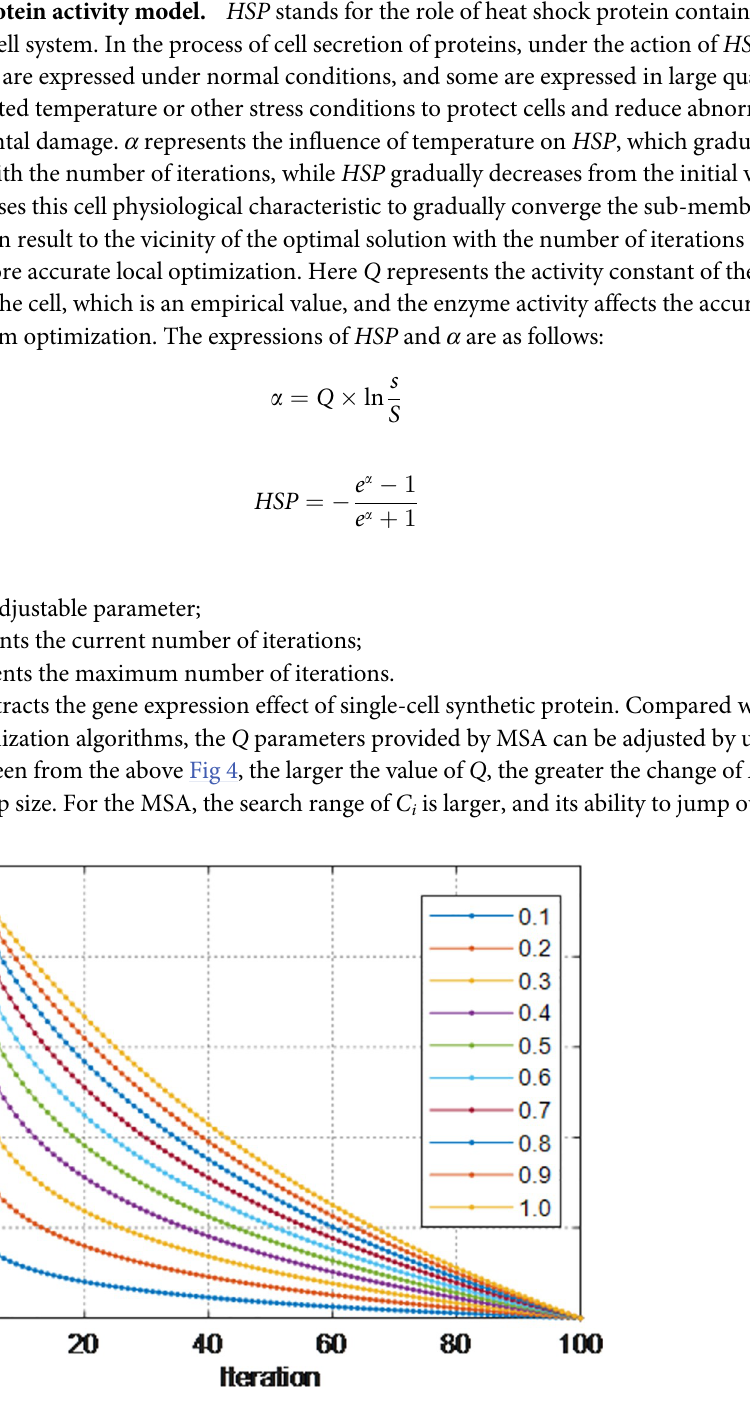
Fig 4. Variation curve of HSP with iteration under different values of Q